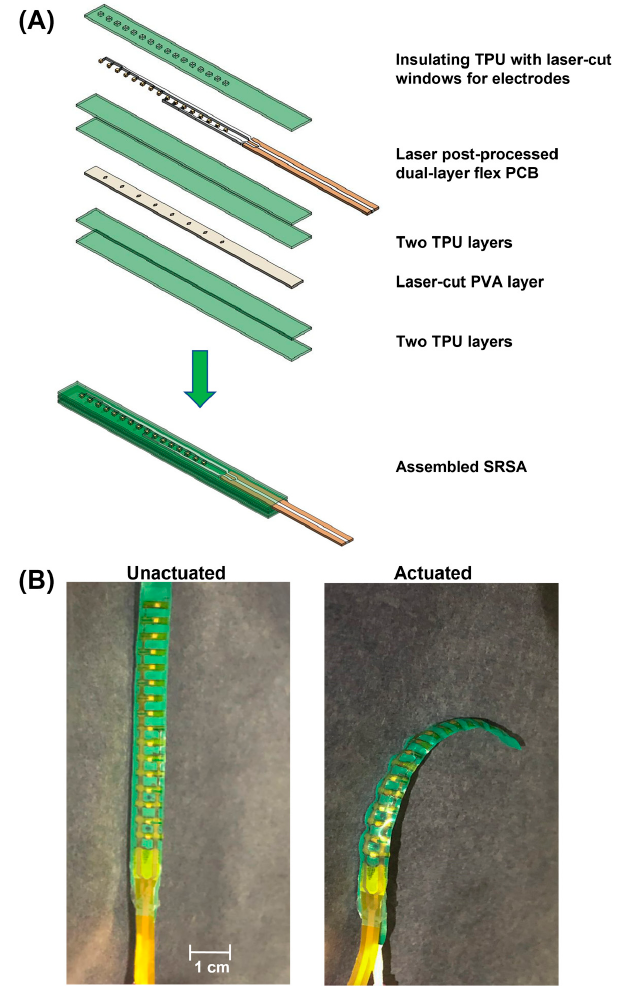
Figure 1. ( A ) Schematic image of layered stack up for the soft robotic sensor array (SRSA) actuator: thermoplastic polyurethane (TPU), flexible printed circuit board (flex-PCB), polyvinyl alcohol (PVA), and soft robotic sensing array (SRSA). ( B ) Real image of the laser postprocessed SRSA actuator before actuation and after actuation.